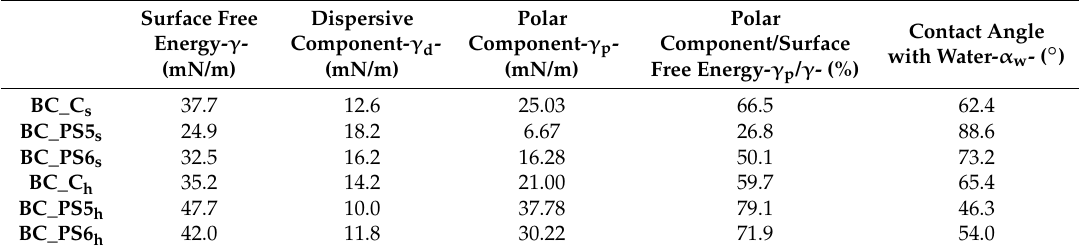
Table 2. Surface free energy of samples: polar and dispersive components and contact angle with